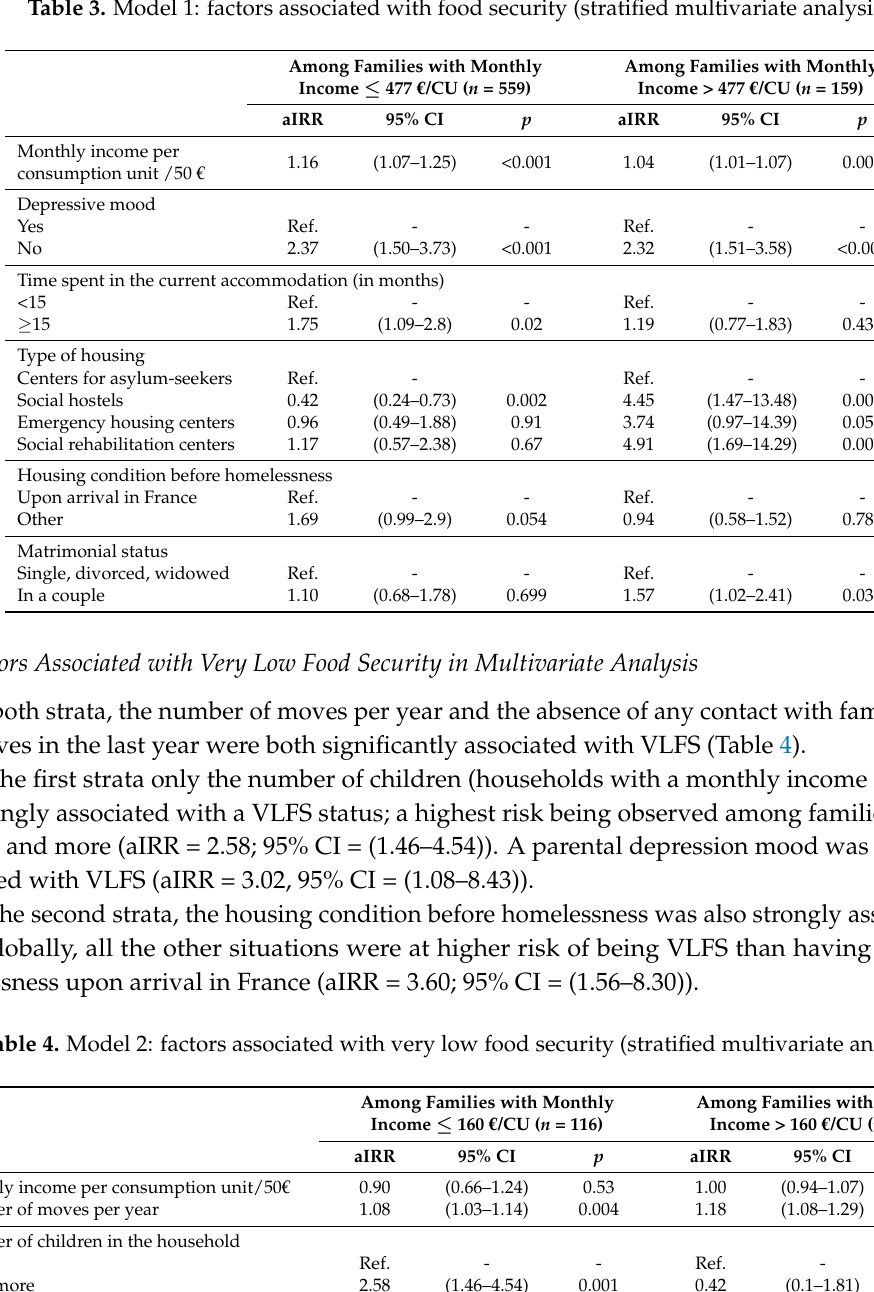
Table 3. Model 1: factors associated with food security (stratified multivariate analysis).